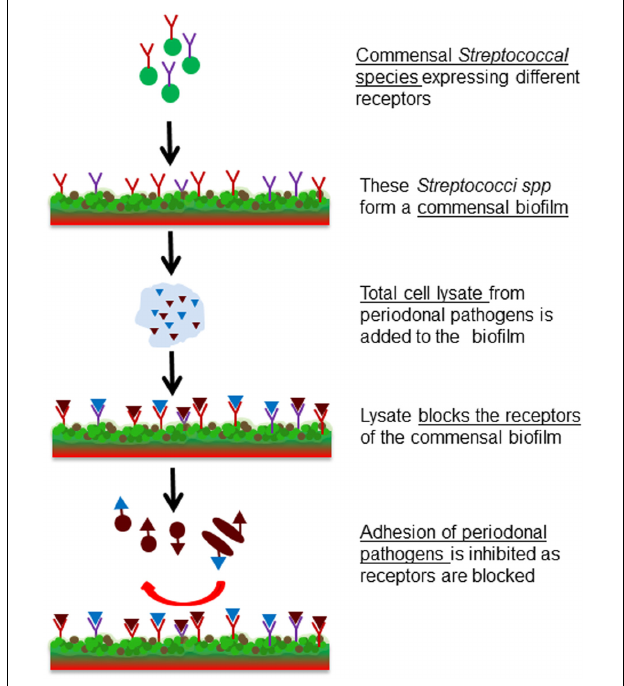
FIGURE 1 | Schematic representation of the project idea. Formation of a commensal biofilm of S. sanguinis whose binding receptors are blocked by the bacterial cell lysate of F. nucleatum or P. gingivalis . Consequently pathogenic colonization is prevented.